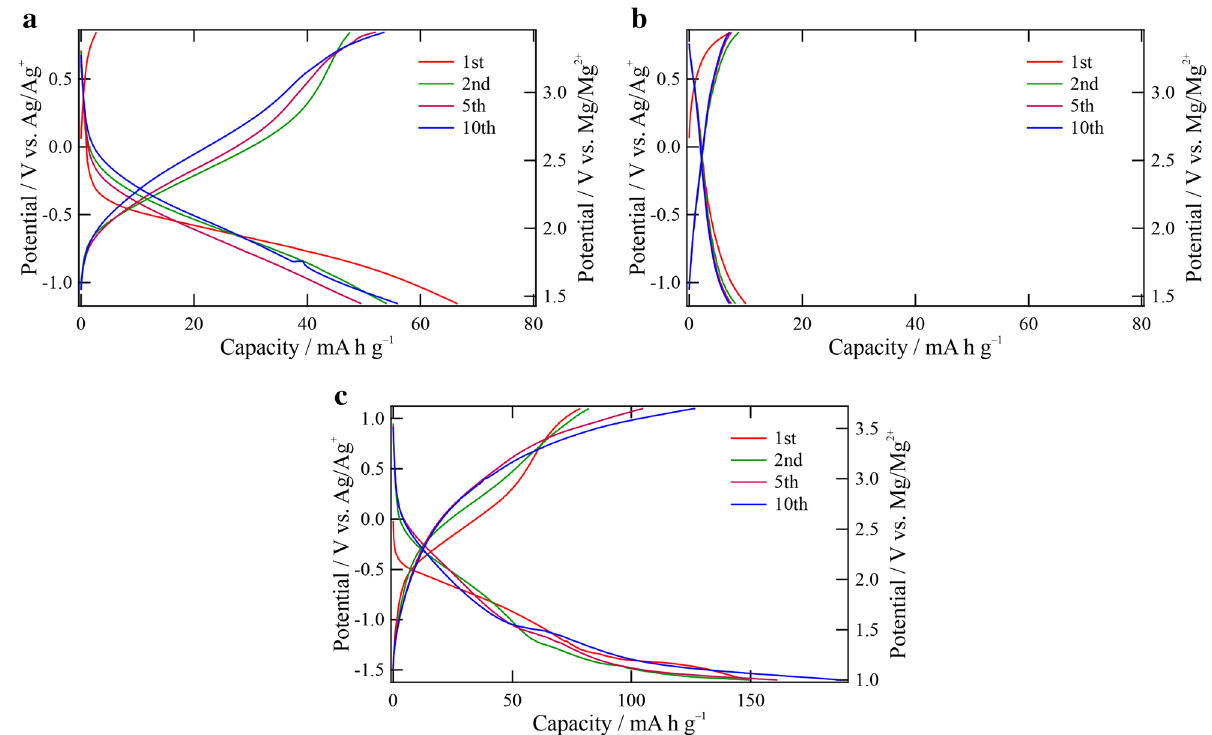
Figure 3. Charge/discharge curves of ( a ) Mg–Fe–O and ( b ) Mg–Ni–O with a cut-off potential of − 1.155 ~ 0.845 V vs. Ag/Ag + (1.445 ~ 3.445 V vs. Mg/Mg 2+ ). ( c ) Charge/discharge curves of Mg–Fe–O with a cut-off potential of − 1.6 ~ 1.1 V vs. Ag/Ag + (1.0 ~ 3.7 V vs. Mg/Mg 2+ ) are also presented. All the measurements were carried out at 90 °C with the current density of 5 mA g –1